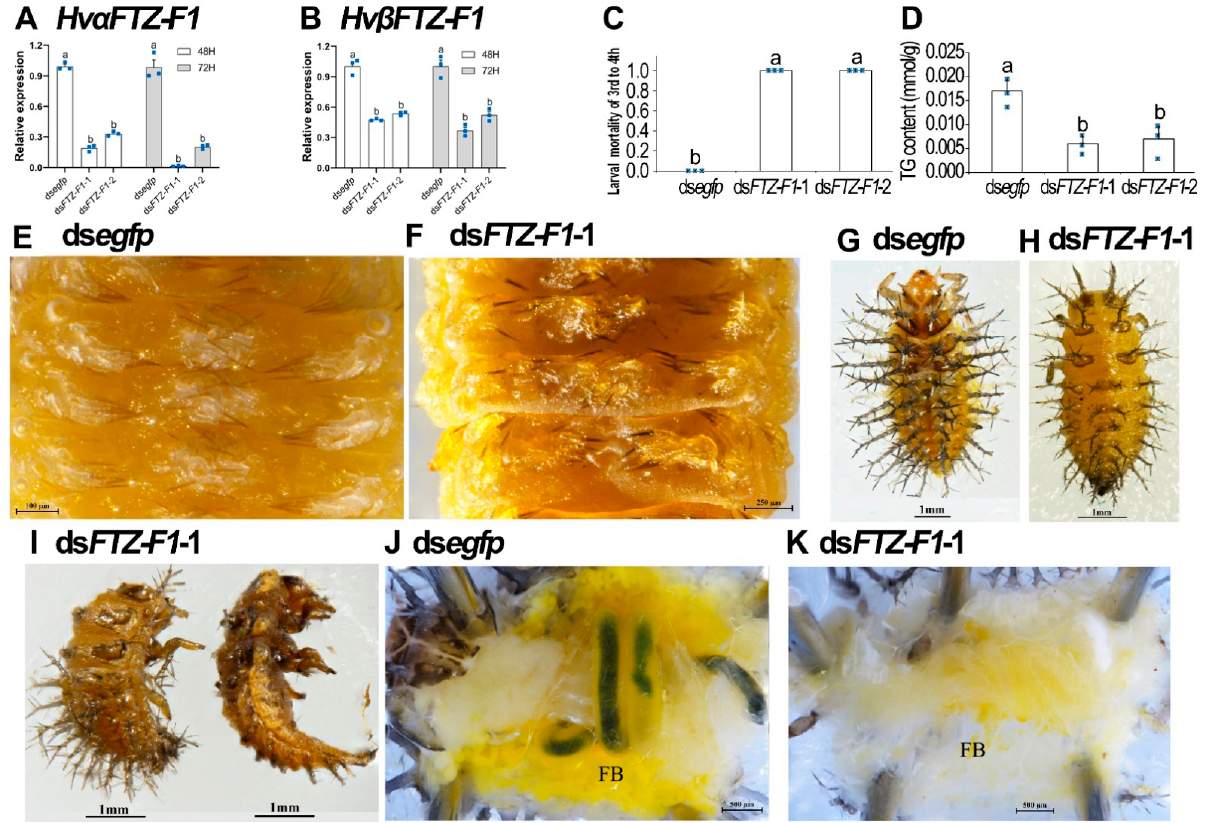
Figure 5. Silencing of both HvFTZ-1 isoforms in the penultimate-instar larvae completely arrested larval–larval ecdysis in Henosepilachna vigintioctopunctata . The newly-ecdysed third-instar larvae were injected with an aliquot (0.1 µ L) of solution including 300 ng ds FTZ-F1 -1 or ds FTZ-F1 -2; both dsRNAs were derived from the common sequences of both isoforms. The same amount of ds egfp was injected as negative control group. The larvae were then transferred to potato foliage. Two and three days after injection, the expression levels of Hv α FTZ-F1 ( A ) and Hv β FTZ-F1 ( B ) were tested. Relative transcripts are the ratios of relative copy number in treated individuals to ds egfp- injected controls, which was set as 1. The larval mortality of 3rd–4th instars was recorded during a 3-week trial period ( C ). The content of triglycerides was measured 3 days after experiment ( D ). Three biological replicates were repeatedly marked with blue dots. The bars represent values ( ± SE). Different letters indicate significant difference at p -value < 0.05. After removing the old larval exuvia, both control and HvFTZ-F1 RNAi larvae formed new cuticles at the late stage of the third-instar larvae ( E , F ). The RNAi larvae failed to molt to the fourth-instar, in contrast to controls ( H ) versus ( G ). The body of the HvFTZ-F1 RNAi larvae bent into a half-moon shape ( I ), with less fat body ( K ) versus ( J ). Silencing HvFTZ-F1 at the third-larval instar stage completely repressed the molt of the resultant larvae. After carefully removing the old larval exuvia, both control and